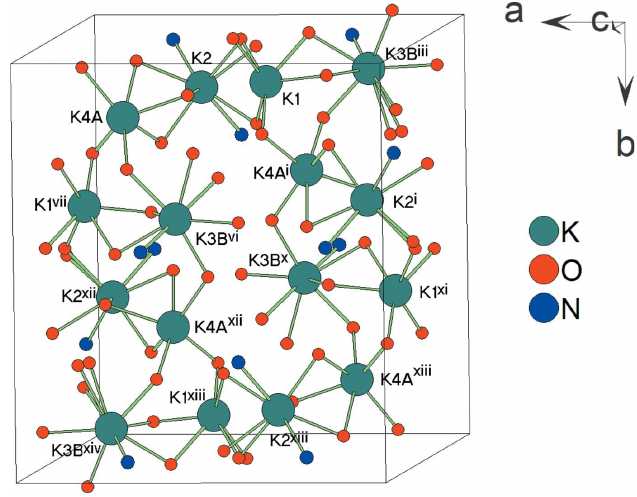
Figure 4 The layer of potassium cations and their coordination arrangement. The minor disordered components of K3 and K4 atoms (K3 A and K4 B ) are omitted for clarity. [Symmetry codes: (i) x (cid:3) 1 , (cid:3) y + 1 , (cid:3) z + 1; (iii) x (cid:3) 1 2 2 (cid:3) z + 1 ; (vi) x , (cid:3) y + 1 , z + 1 ; (vii) x + 1 , (cid:3) y + 1 , (cid:3) z + 1; ( x ) (cid:3) x + 1, y + 1 2 2 2 2 2 (cid:3) z + 1 ; (xi) (cid:3) x + 1 , y + 1 , (cid:3) z ; (xii) (cid:3) x + 3 , y + 1 , z ; (xiii) x + 1, (cid:3) y + 1, (cid:3) z + 1; 2 2 2 2 2 (xiv) (cid:3) x + 2 , (cid:3) y + 1, z + 1 ]. 3 2